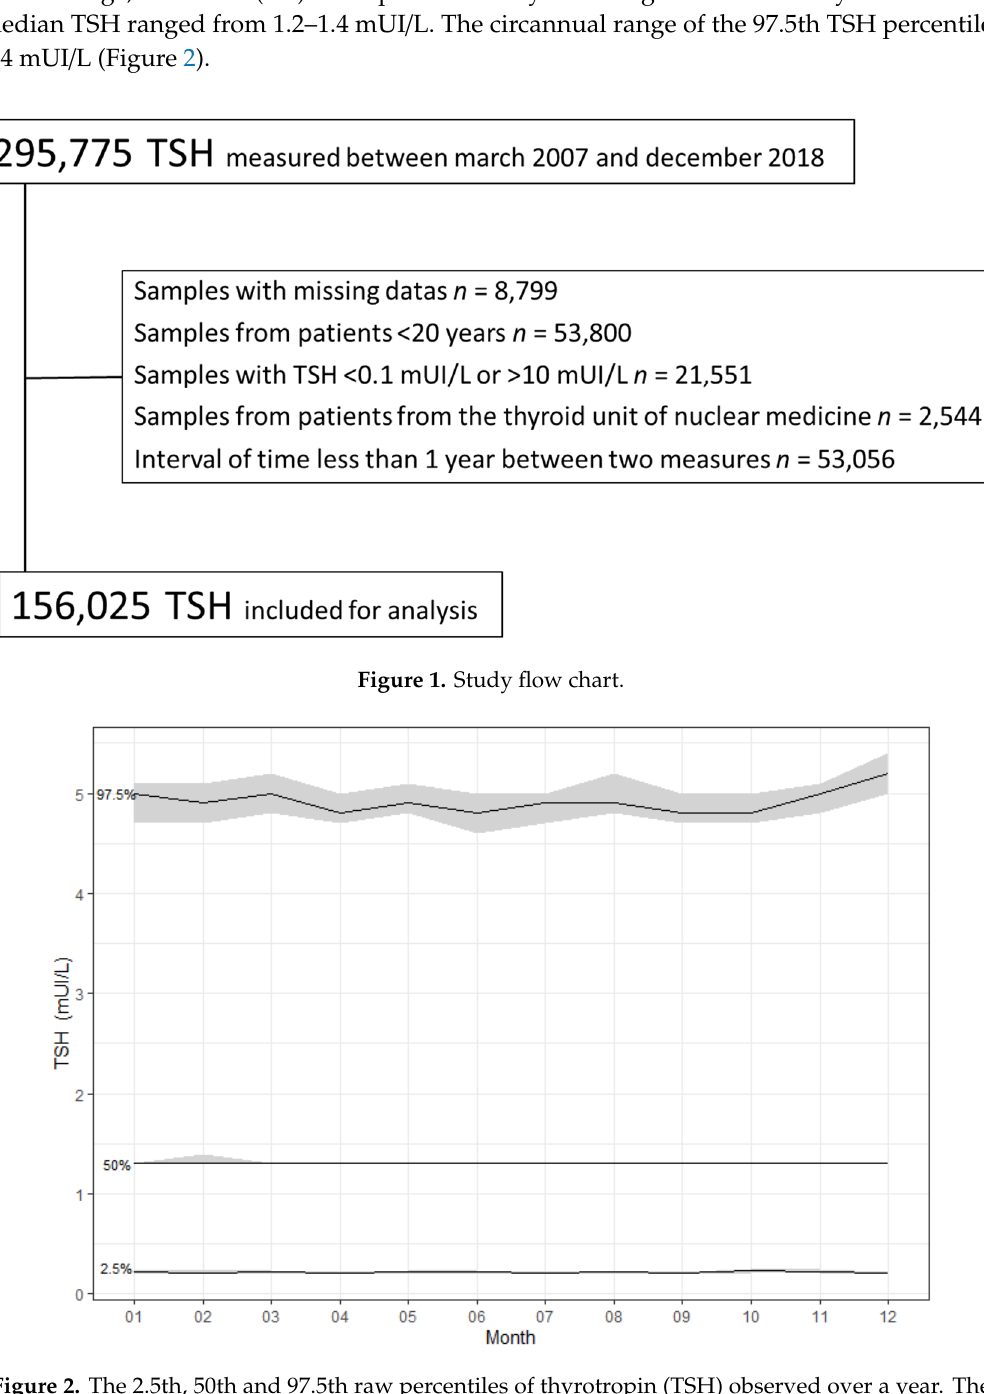
Figure 2. The 2.5th, 50th and 97.5th raw percentiles of thyrotropin (TSH) observed over a year. The grey area corresponds to the 95% confidence intervals of the quantiles.